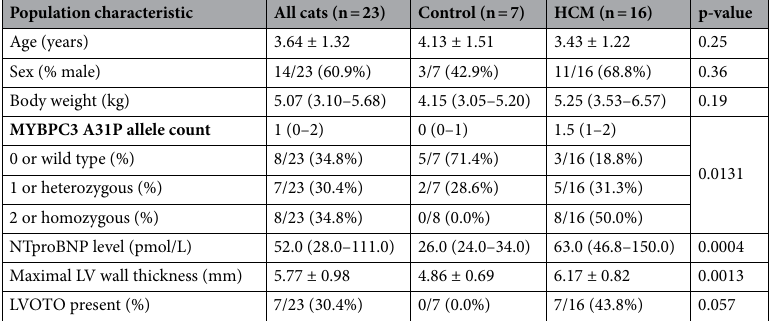
Table 1. Study population characteristics including signalment, genotype for the A31P MYBPC3 mutation, NTproBNP measurement, maximal left ventricular wall thickness, and presence of left ventricular outflow tract obstruction on echocardiogram. Data are displayed as mean ± SD or median (IQR). Comparison is made between groups with p-values displayed.